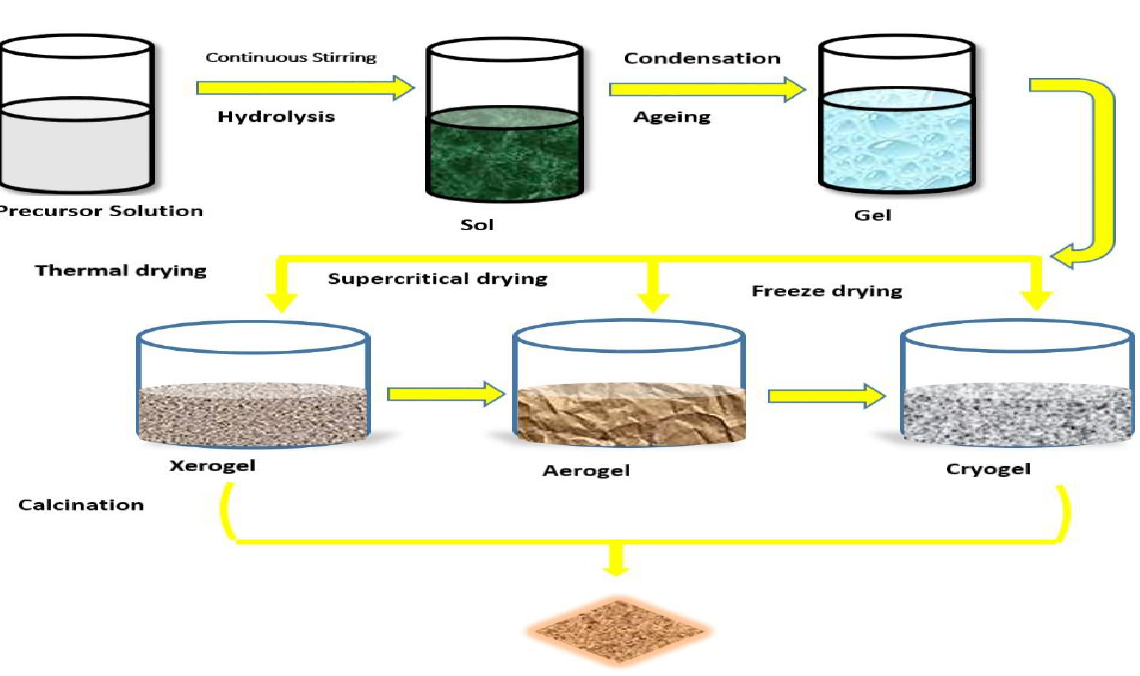
Figure 4. Sol-gel technique.